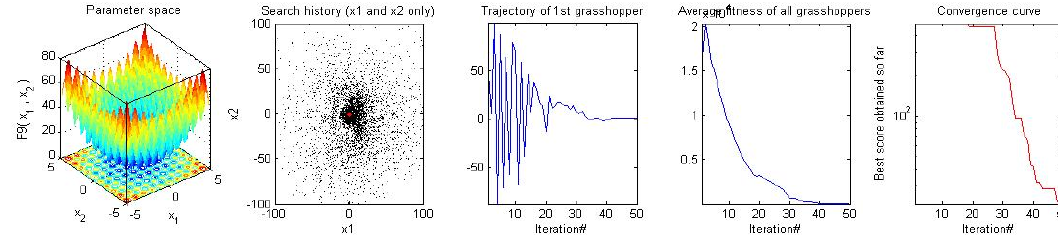
Figure 10. HAGOA behavior on multimodal function